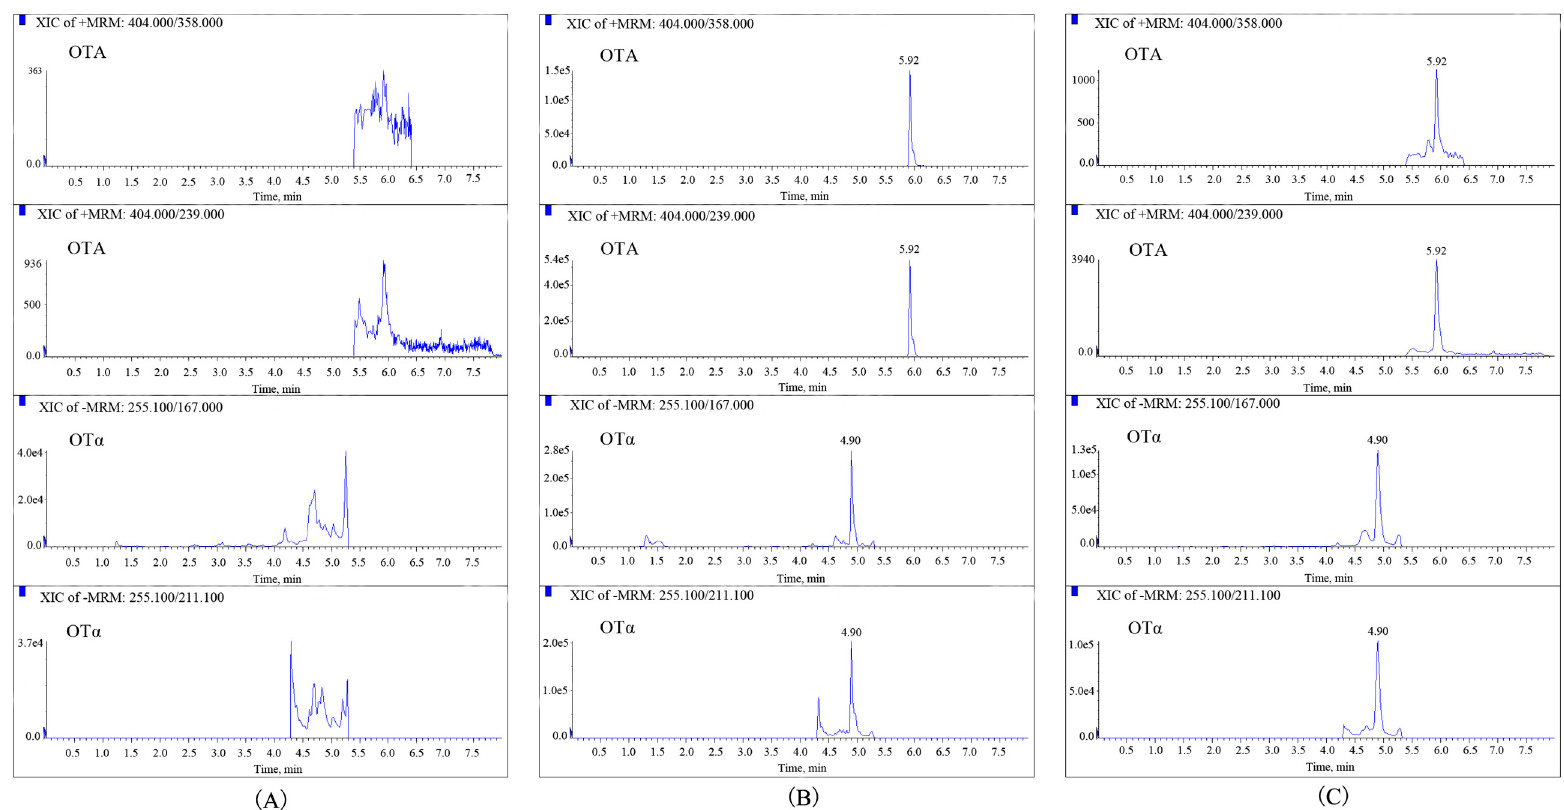
Figure 1. Multiple reaction monitoring (MRM) chromatograms of ochratoxin A (OTA) and ochratoxin α (OT α ) in a blank urine sample ( A ), in spiked urine sample with the concentration of 20 ng mL − 1 ( B ), and in urine samples collected at 12 h after oral administration of OTA in dairy cows ( C ).